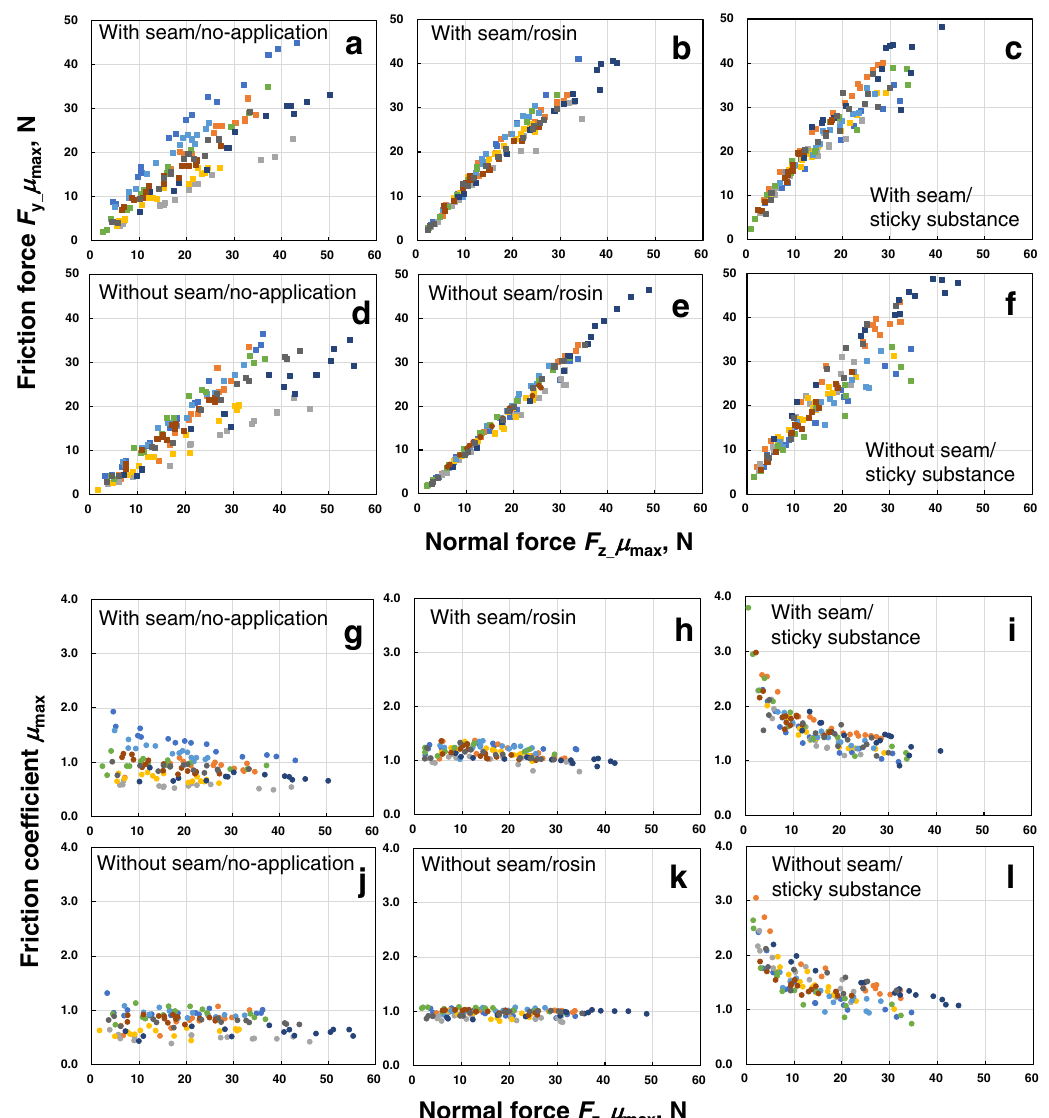
Fig. 2 Frictional characteristics for MLB ball under each application condition. a – f Relation between the horizontal force F y_ μ max and normal force F z_ μ max at the instant of each maximum value of the friction coef fi cient µ max for each participant (with different plot color) under each application condition for MLB ball. No application with seam ( a ), rosin application with seam ( b ), sticky substance application with seam ( c ), no application without seam ( d ), rosin application without seam ( e ), and sticky substance application without seam ( f ). g – l Relation between µ max and normal force at µ max under each application condition for MLB ball. No application with seam ( g ), rosin application with seam ( h ), sticky substance application with seam ( i ), no application without seam ( j ), rosin application without seam ( k ), and sticky substance application without seam ( l ).